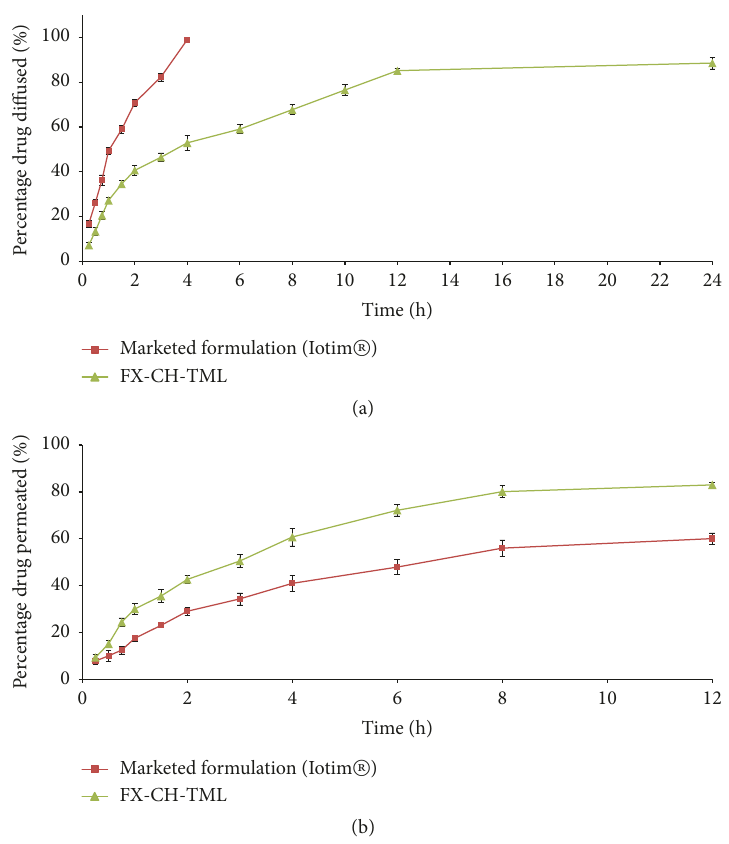
Figure 6: (a) In vitro drug release profile of TML from FX-CH-TML nanoparticles and marketed formulation; (b) ex vivo transcorneal permeation profile of TML from FX-CH-TML nanoparticles and marketed